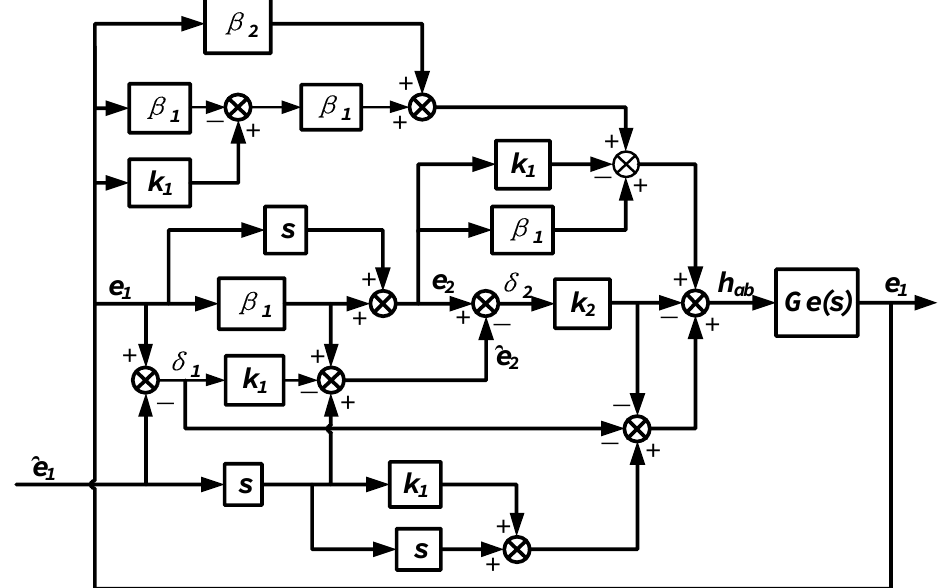
Figure 3. Backstepping controller structure diagram.